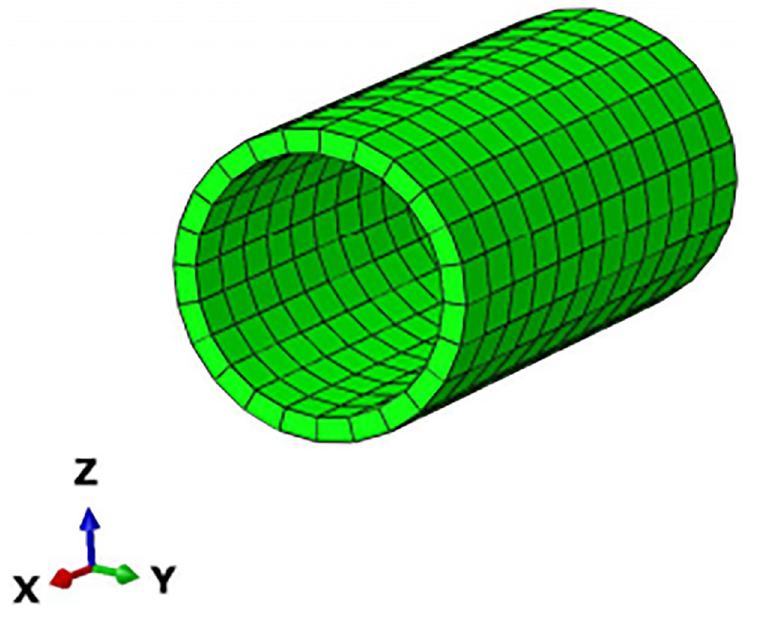
Fig 7. Pipe model meshing